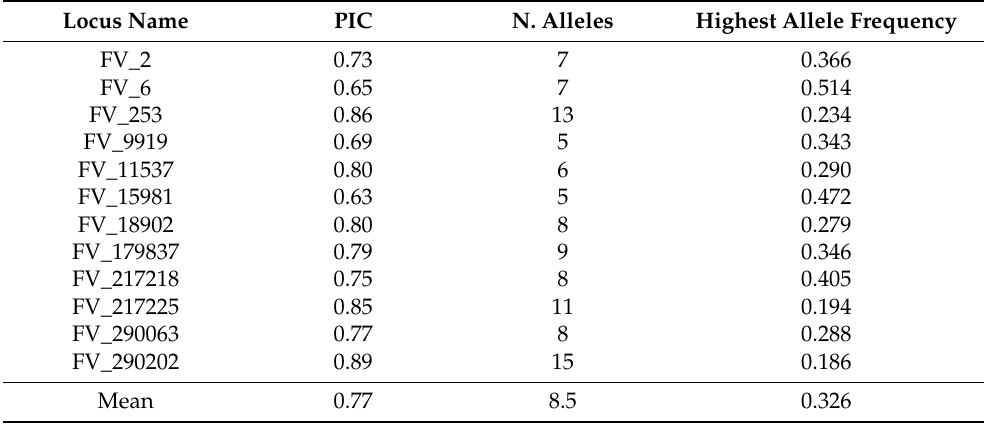
Table 2. Descriptive statistics of SSR markers reporting the polymorphic information content (PIC), number of marker alleles per locus and the highest marker allele frequency observed per locus (PIC coefficients are calculated as Nei’s diversity, in agreement with Palumbo and Serrote [11,16]). Locus Name PIC N.